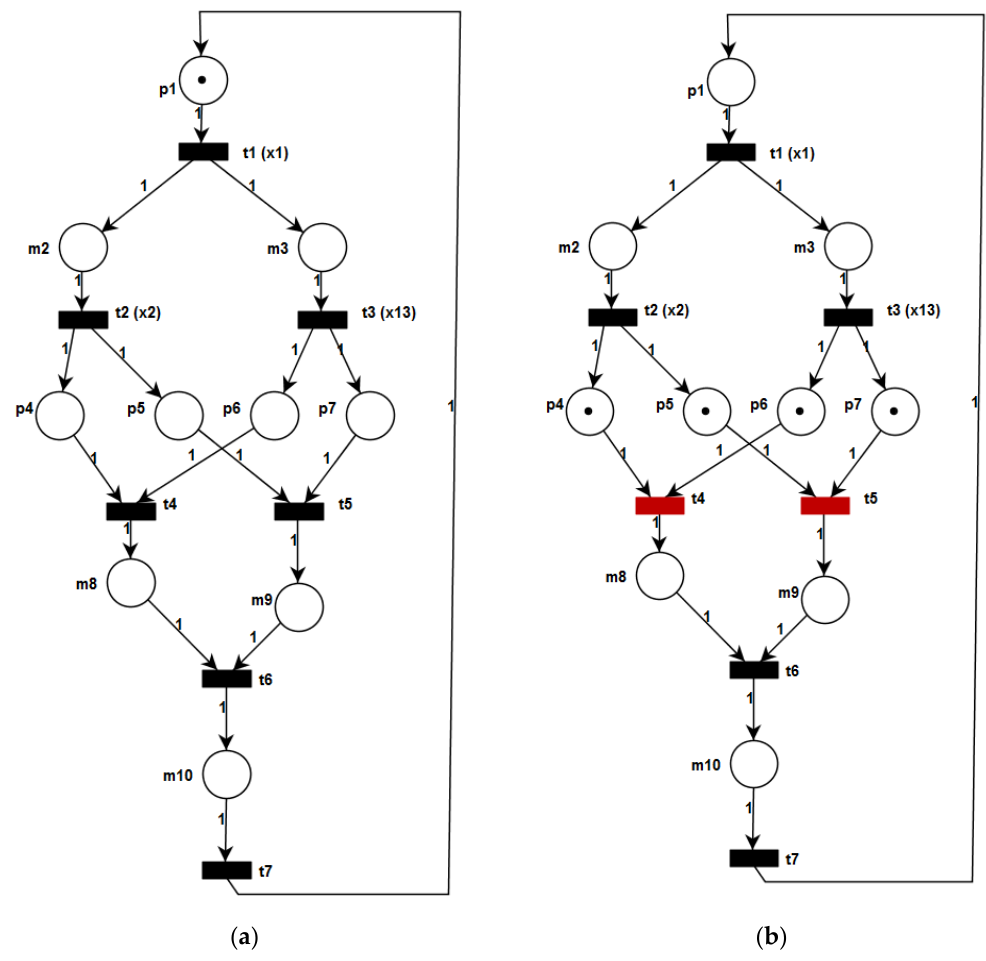
Figure 8. Model of the top module ( a ) and its simulation ( b ) in PIPE.